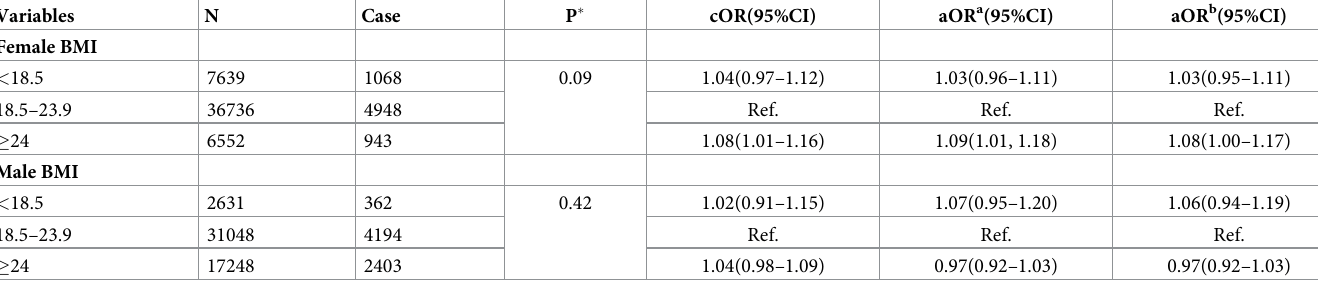
Table 4. Association between pre-pregnancy BMI and subfecundity in men and women, logistic regression analysis.